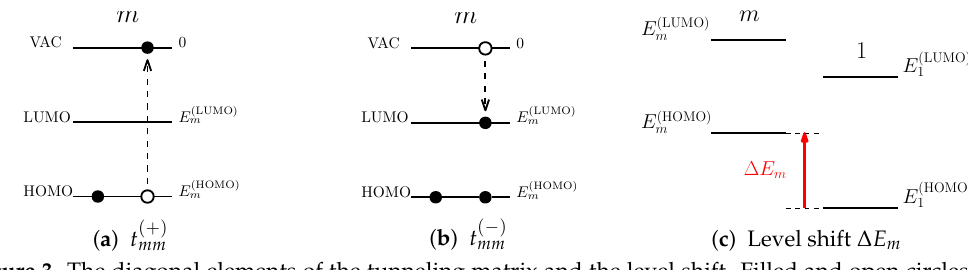
Figure 3. The diagonal elements of the tunneling matrix and the level shift. Filled and open circles represent electrons and holes respectively and VAC represents the vacuum level whose energy value is (+) zero. The arrows with dashed lines represent the direction of electron transfer. ( a ) t mm is the amount ( − ) of energy to create a hole in HOMO. ( b ) t mm is the amount of energy to create an electron in LUMO.